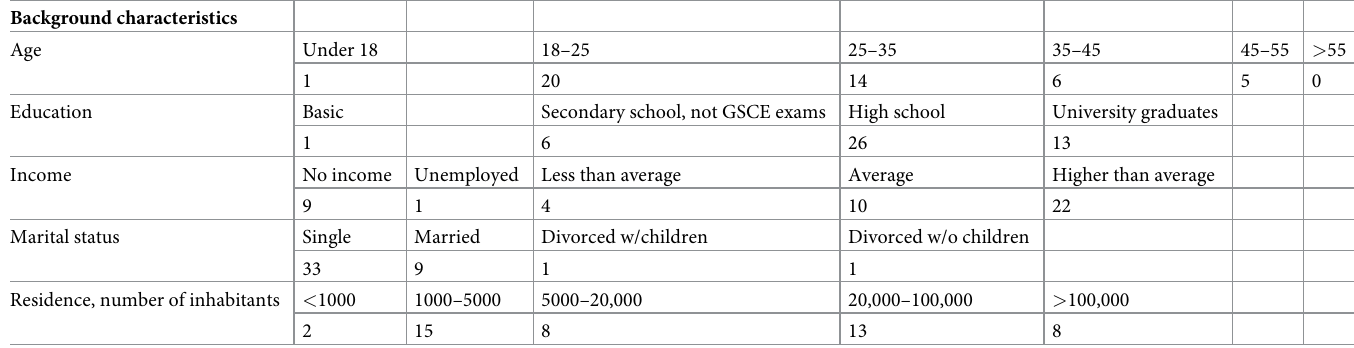
Table 1. Background of